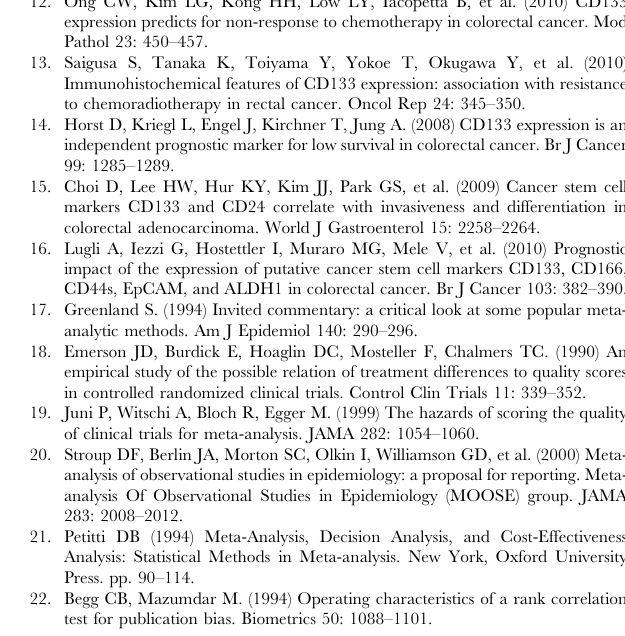
Figure S1 CD133 expression and T category. Figure S2 CD133 expression and N category. Figure S3 CD133 expression and vascular invasion. Figure S4 CD133 expression and histologic types. Figure S5 CD133 expression and lymphatic invasion. Figure S6 CD133 expression and distant